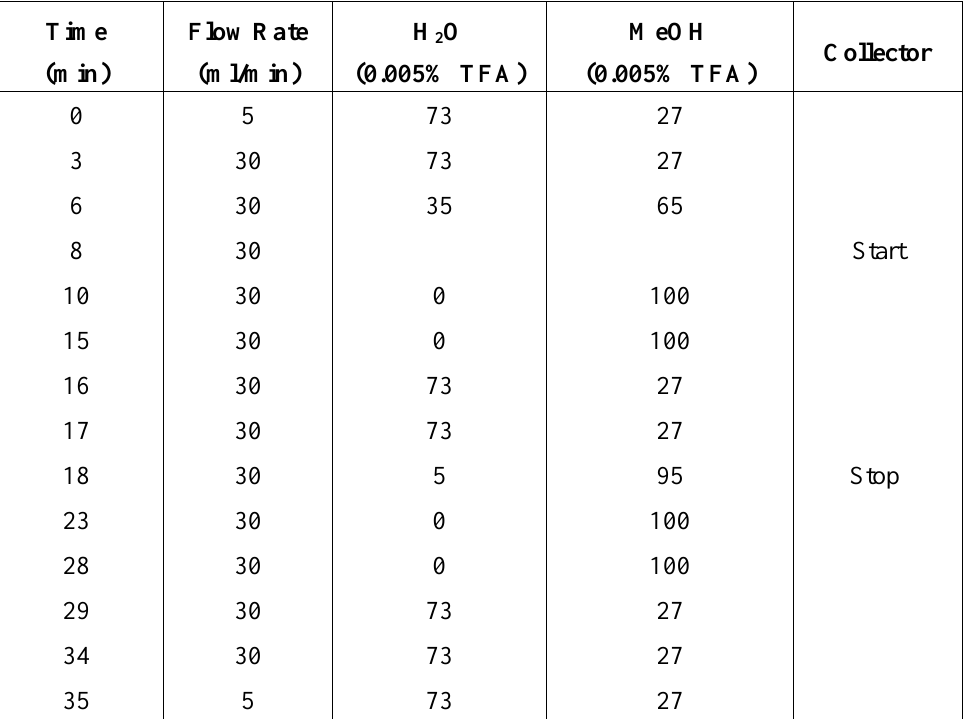
Table 1. Gradient solvent system used to generate the pre-fractionated library by preparative